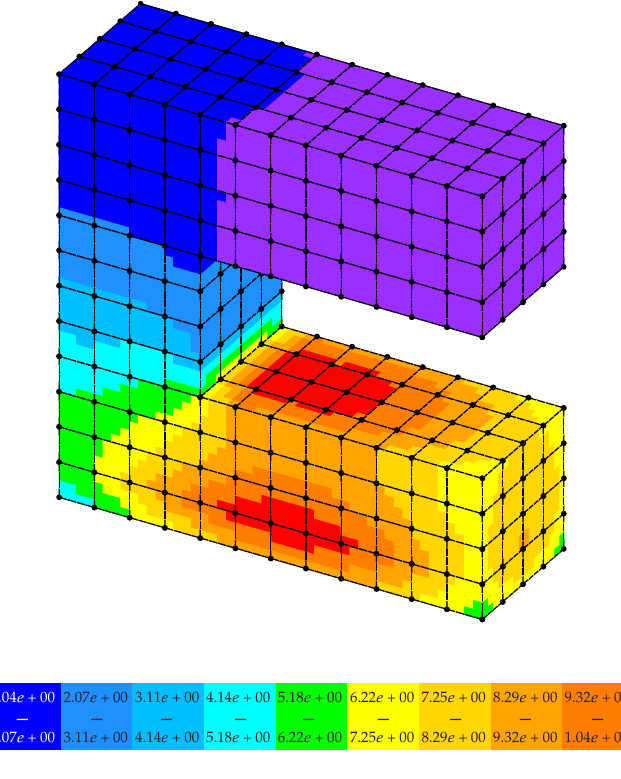
Figure 5.1. Outgoing radiative flux q 0